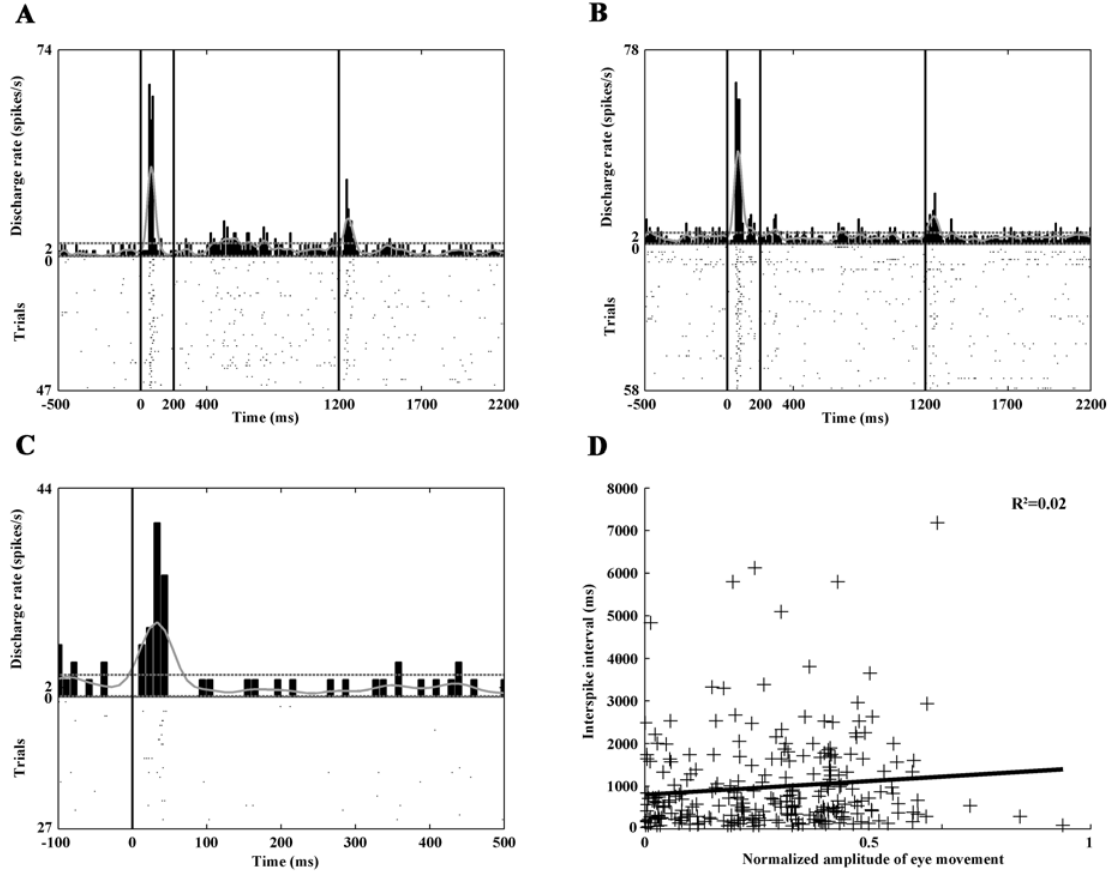
Fig 5. Stimulation-related response of a PAN. The PSTHs in panels A and B show the activity of the neuron in response to stimulation. A: response to center-out optic flow. B: response to center-in optic flow. The response to random dot patterns (A,B), to center-out optic flow (A) but not to center-in (B) and the beginning of the reward phase are readily observable (A,B). The conventions are the same as in Fig 3. In order to decide whether the increased activity at the beginning of the reward phase is purely reward-related or related to stimulus offset, the aborted trials (where the cat had broken the fixation during visual stimulation and therefore got no reward) were also analyzed (C). Panel C is aligned to the time of the breaking of the fixation, which corresponded to the offset of the stimulus because the trial was immediately aborted upon fixation breaking. Note the PSTH peak, which indicates responsiveness to the offset of the stimulus. Furthermore, in order to control for the effects of saccadic activity, the correlation between the interspike intervals and the normalized amplitude of the eye movements recorded during the experiment was computed (D). The linear regression analysis clearly shows the lack of connection ( ρ 2 : 0.02, p > 0.05). This means the activity is of no saccadic